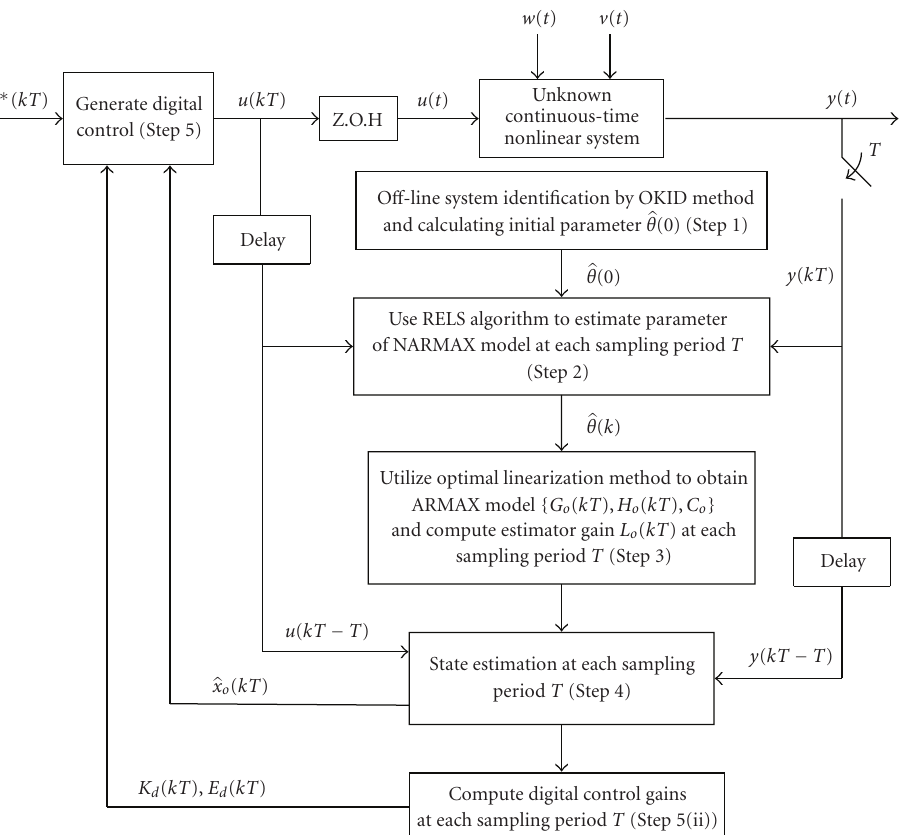
Figure 3: Structure of the hybrid state-space self-tuning control with NARMAX model and OKID for unknown nonlinear stochastic hybrid